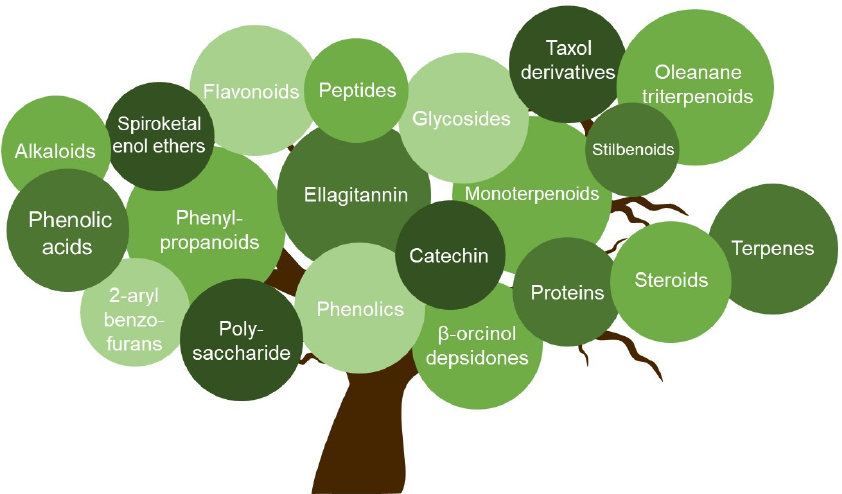
Figure 1. Classification of antiherpetic agents derived from natural sources. Natural sources such as plants or fungi are rich in different groups of bioactive compounds. Several of these groups (e.g., alkaloids, terpenes, polysaccharides, flavonoids, phenolic acids, and steroids) were identified as antiviral active agents against HSV-1 and HSV-2. Table 1. Chemical compounds and their anti-HSV activity. CC 50 = 50% cytotoxic concentration, EC 50 = 50% effective con-